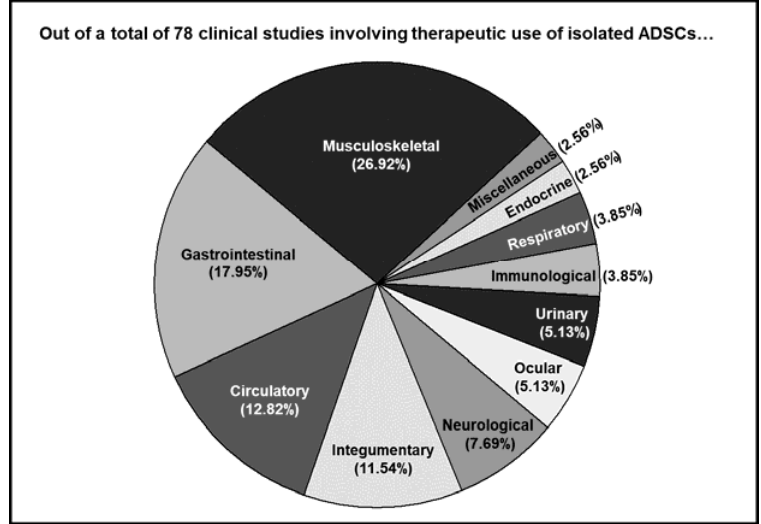
Figure 1. Different disorders subjected to isolated ADSC-based therapeutics are categorized by the systems the targeted tissue/organ belong to, and the ratio of each category is indicated. systems the targeted tissue/organ belong to, and the ratio of each category is